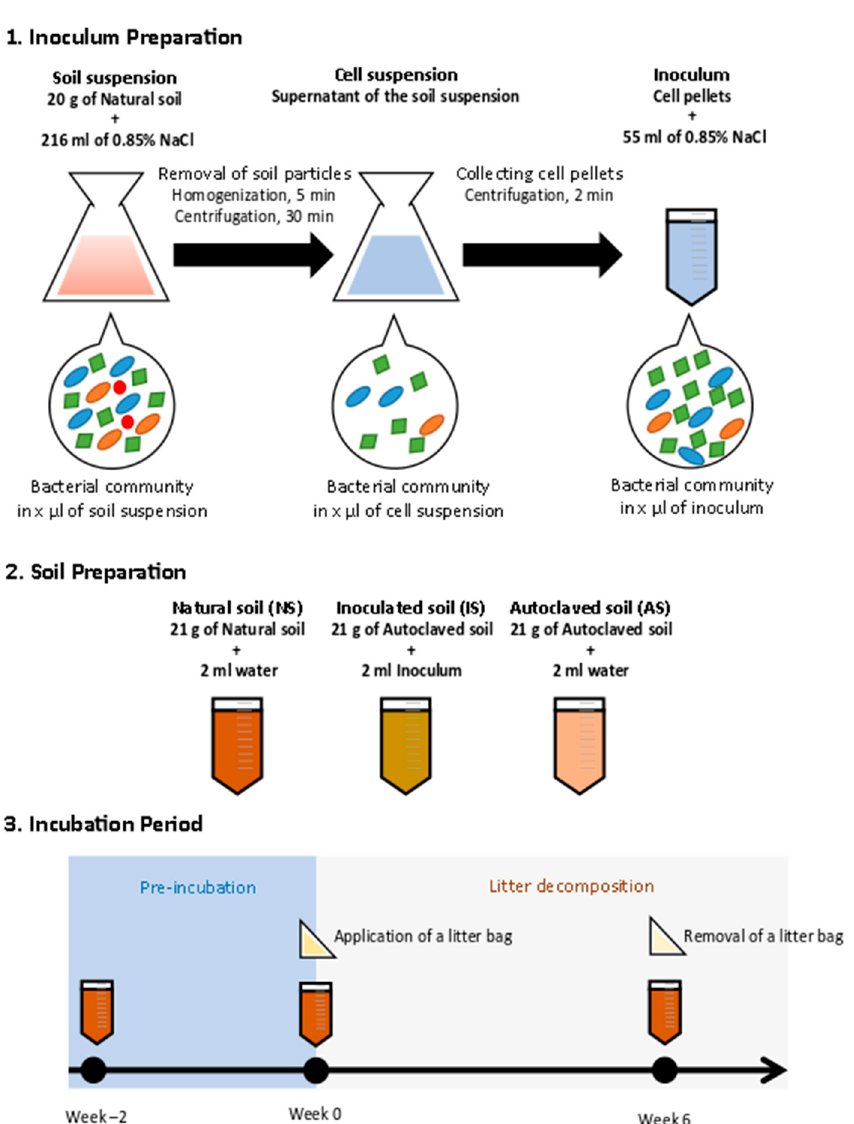
Figure 1. Schematic diagram of the experimental setup for the preparation of microbial inoculum and soils, and the incubation